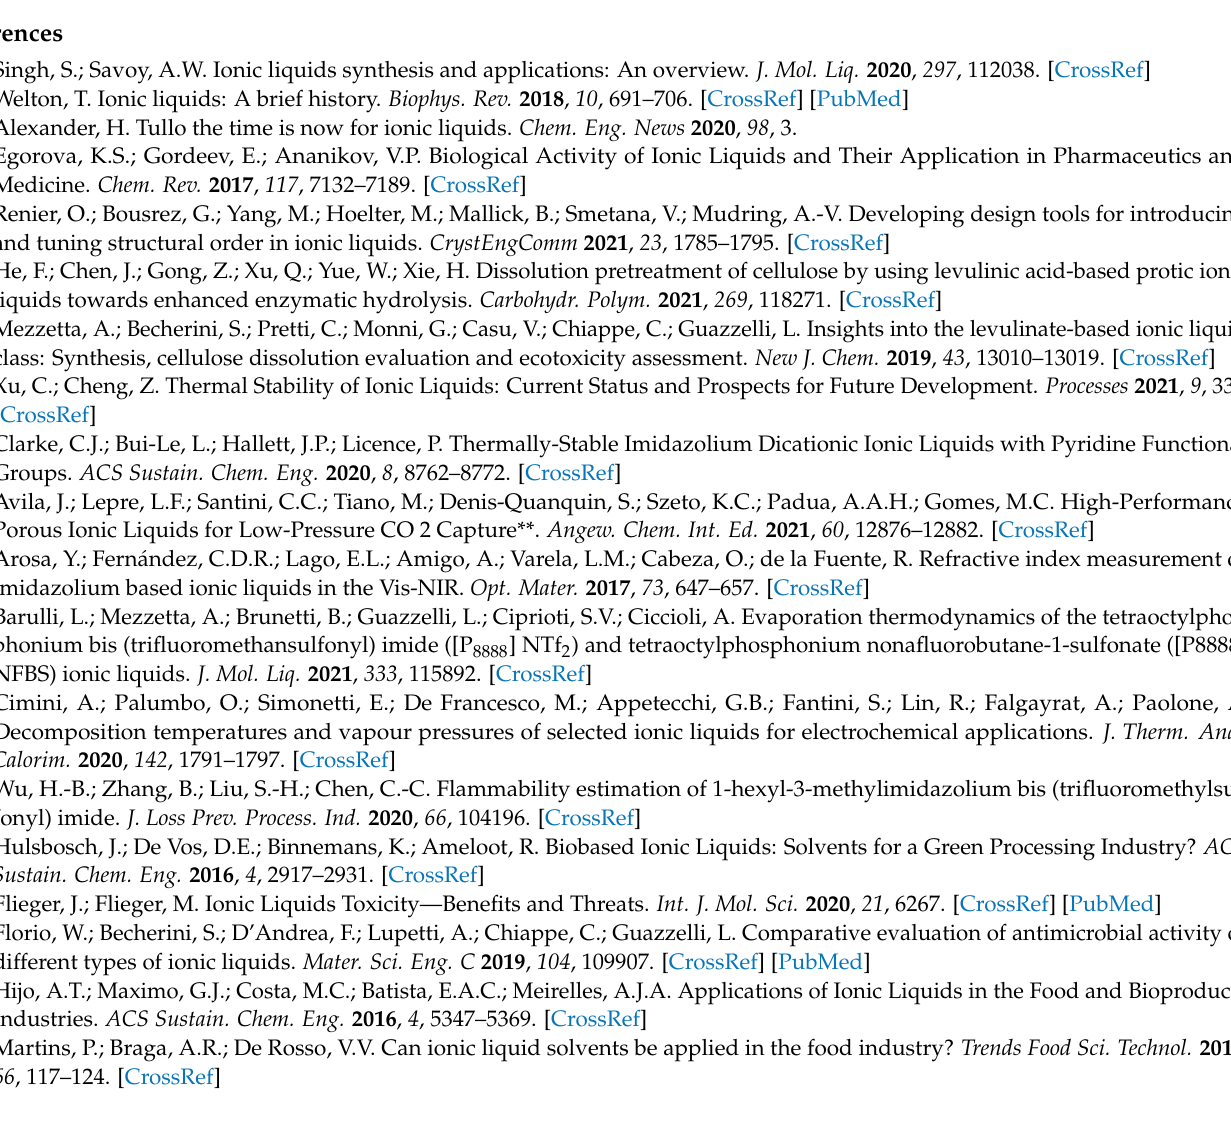
Table S3. Glass transition temperature (T g ), crystallization temperature (T c ), cold crystallization temperature (T cc ), and melting temperature (T m ) of the investigated ionic liquids measured at second heating run, Table S4. Apparent activation energy (E a ), consequently its fragility index (m), and glass transition temperature (T g /K) of compounds